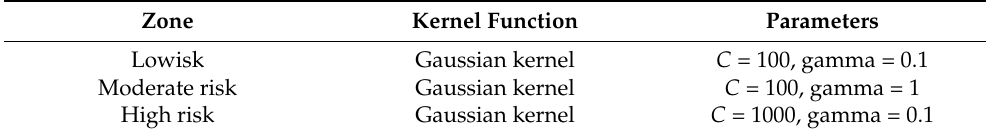
Table 5. Model parameters of